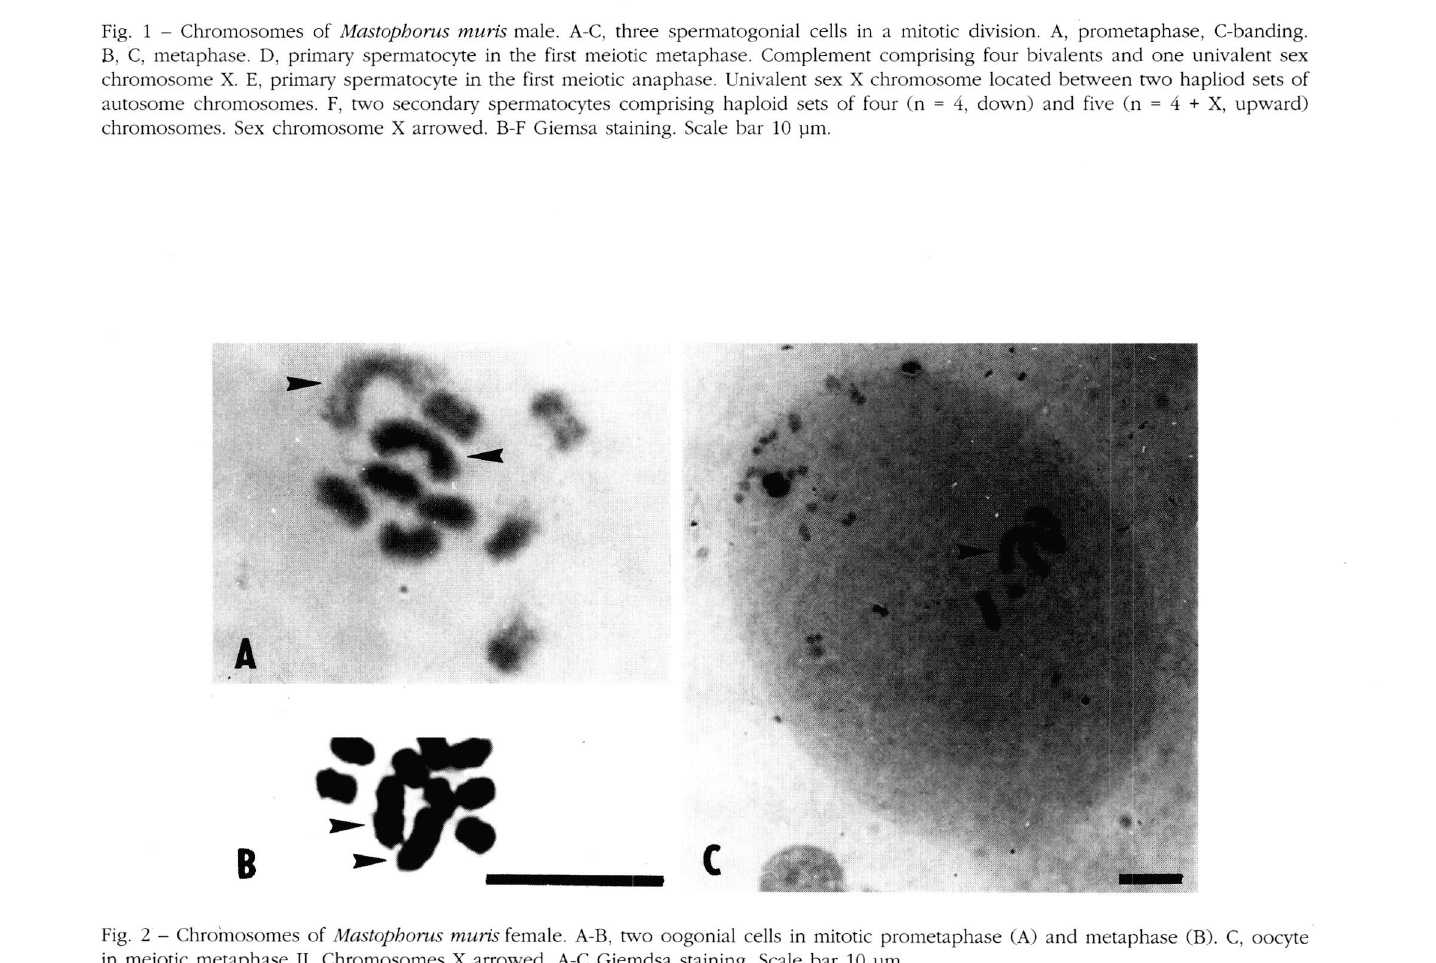
Fig. 2 - Chromosomes of Mastophorus muris female. A-B, two oogonial cells in mitotic prometaphase (A) and metaphase (B). C, oocyte in meiotic metaphase II. Chromosomes X arrowed. A-C Giemdsa staining. Scale bar 10